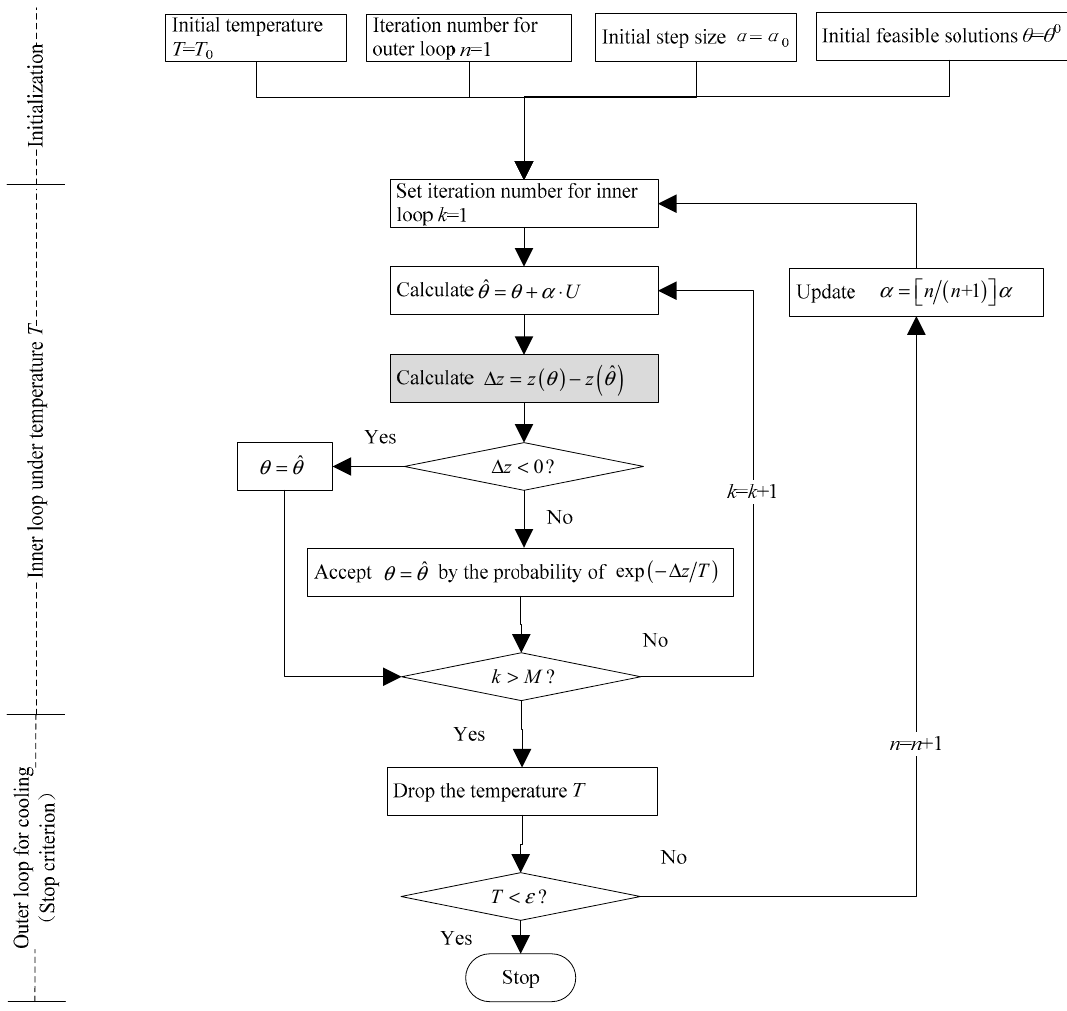
Figure 3. A flowchart for the simulated annealing (SA) algorithm.